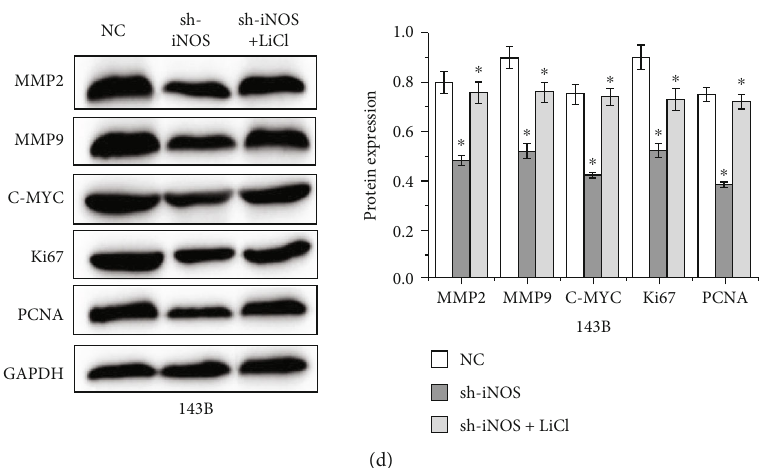
Figure 3: iNOS promotes OS progression via Wnt/ β -catenin pathway. (a) The iNOS and β -catenin expressions in Saos2 and 143B cells treated with Wnt/ β -catenin pathway inhibitor IWP-1 ( ∗ p < 0 : 05 ). (b) The β -catenin expressions in Saos2 and 143B cells treated with NC, Wnt/ β -catenin pathway activator LiCl, and sh-iNOS+LiCl ( ∗ p < 0 : 05 ). (c, d) The expressions of MMP2, MMP9, C-MYC, Ki67, and PCNA in Saos2 and 143B cells treated with NC, sh-iNOS, and sh-iNOS+LiCl ( ∗ p < 0 : 05